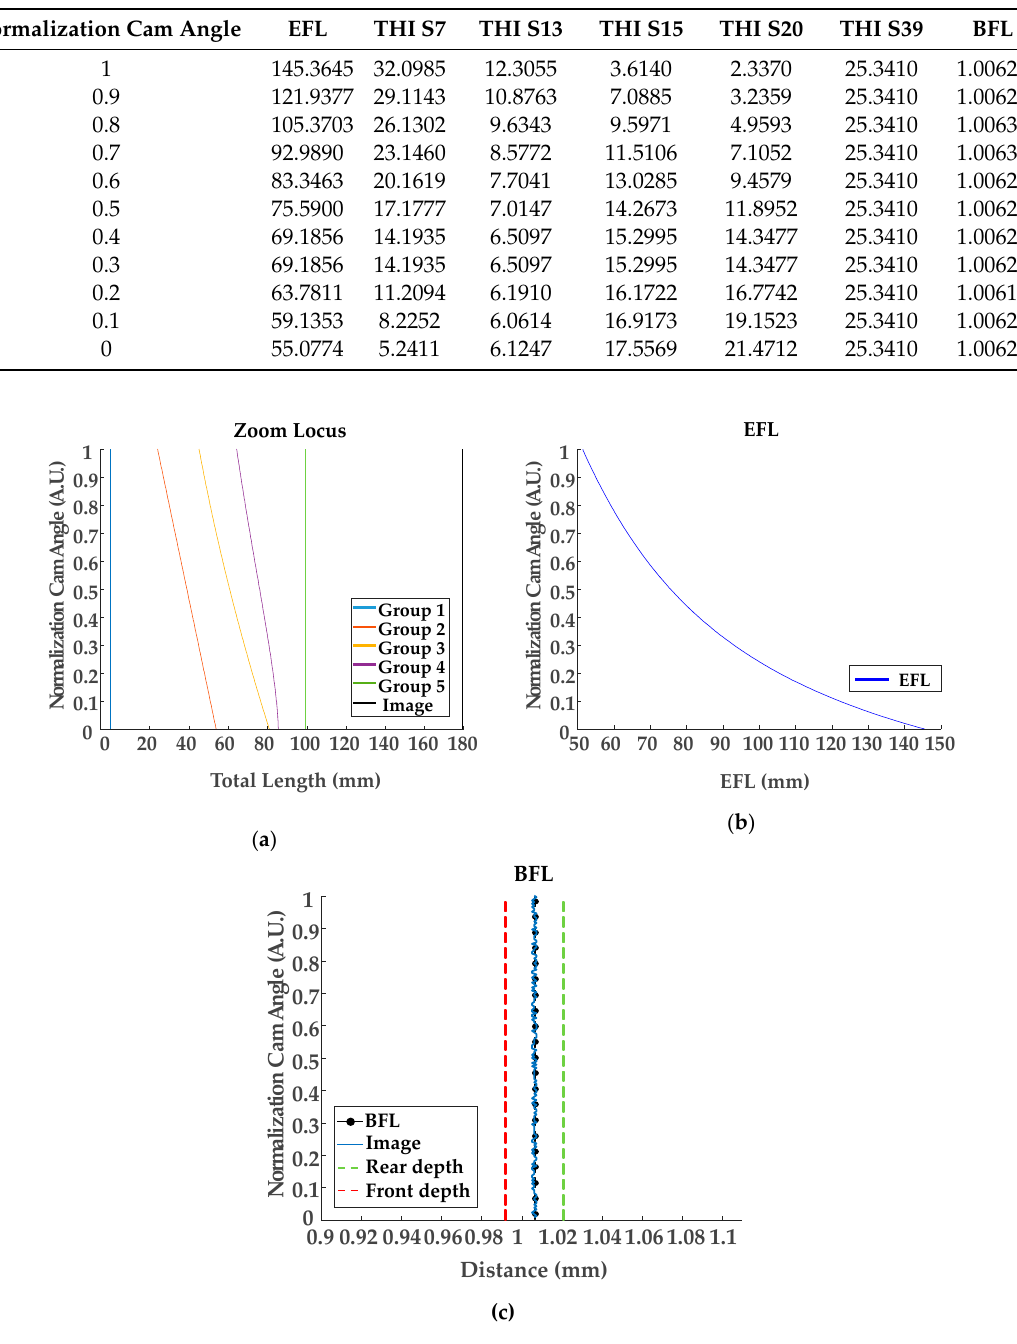
Figure 12. Graphs of the reapplication of the Padé approximation after correcting BFL by moving the fourth lens group from the results in Table 11. ( a ) Zoom locus of each lens group, ( b ) EFL of this optical system, and ( c ) error for image plane. Table 12. Coefficients of the rational function for each lens group calculated by the Padé approximation shown in Table 11.